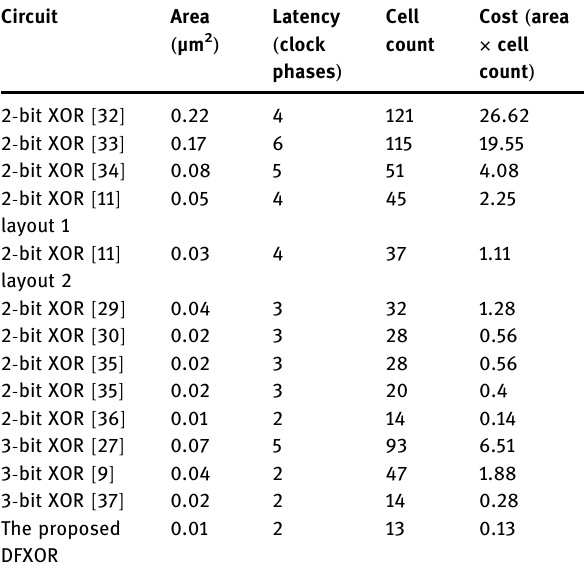
Table 2: Result comparison table